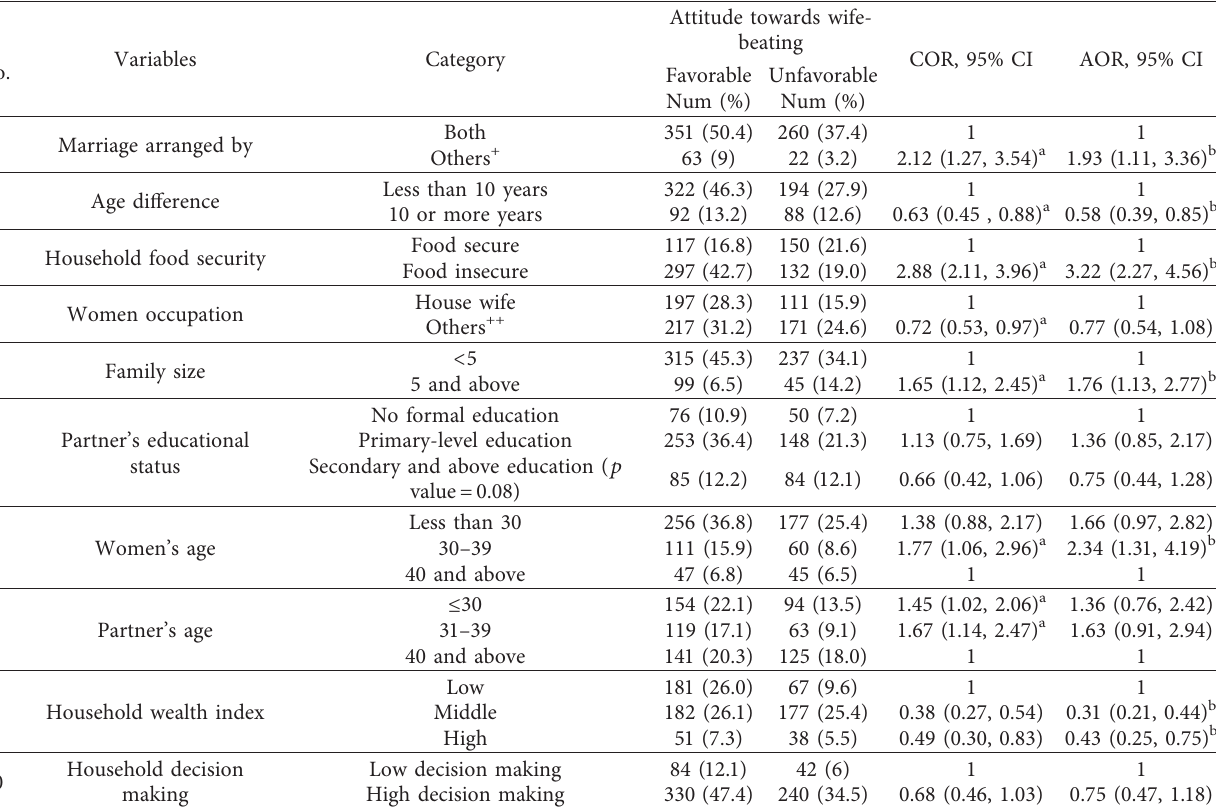
Table 3: Factors associated with attitude towards wife-beating among currently married women at Arba Minch town, Southern